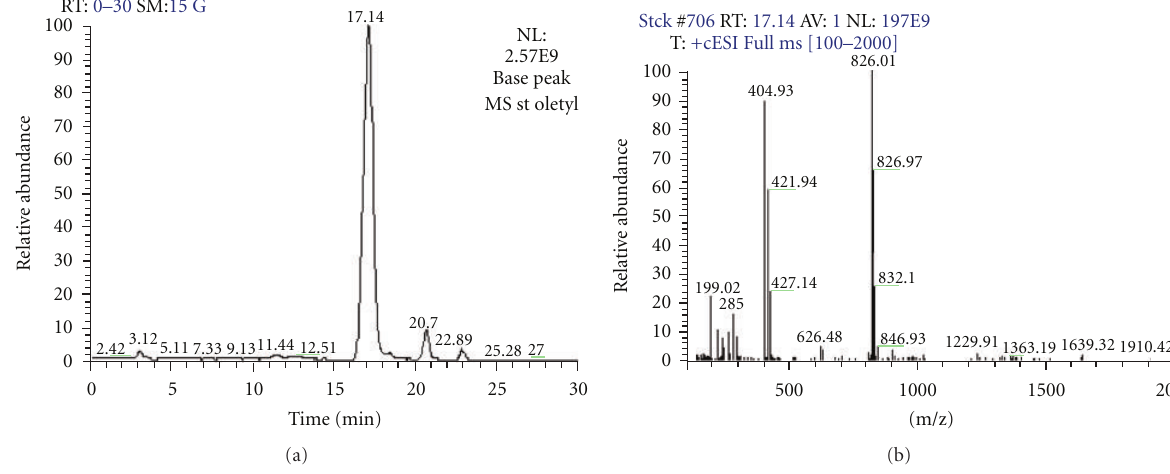
Figure 6: MS chromatogram profile of the MKL standard. (a) MS chromatogram, (b) MS